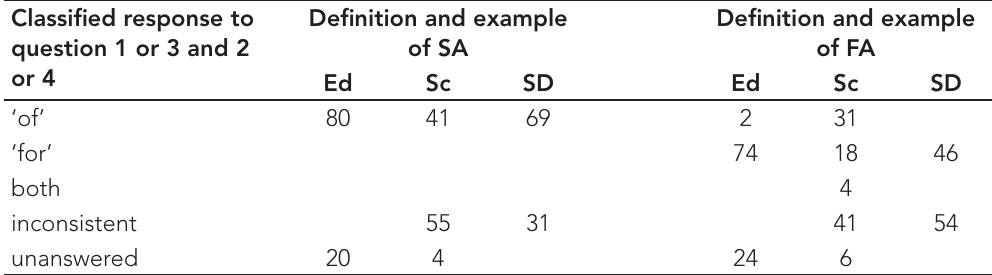
Table 5: The consistency of classified responses comparing first definitions given with examples for both SA and